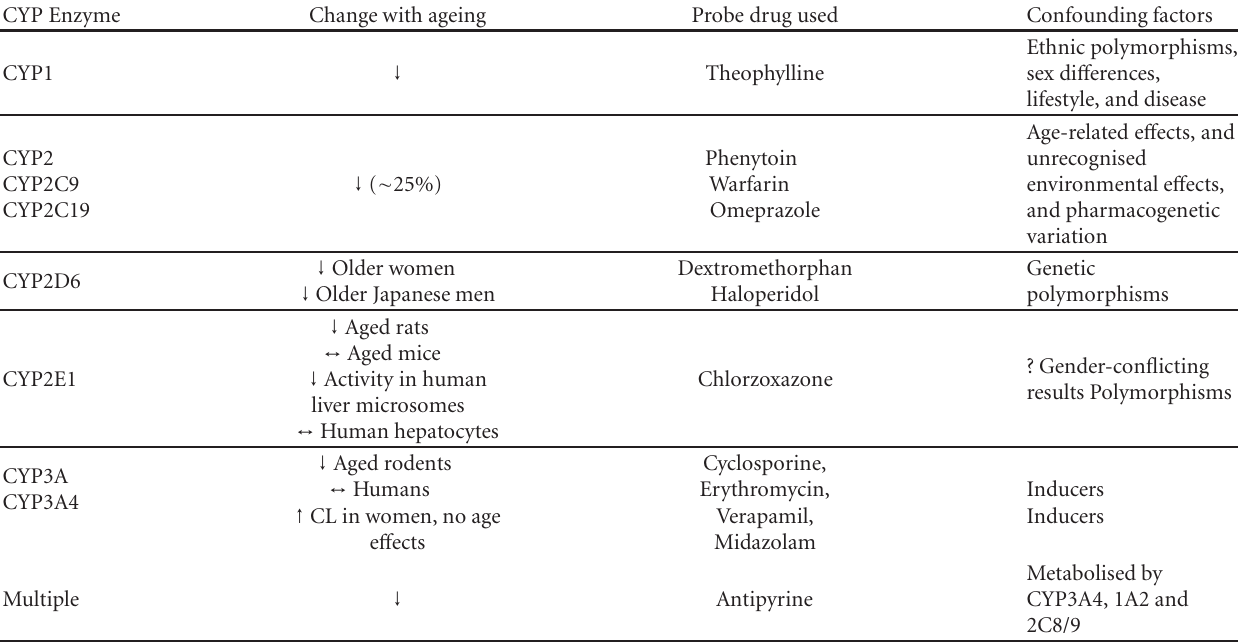
Table 2: Changes in the cytochrome P450 activity with